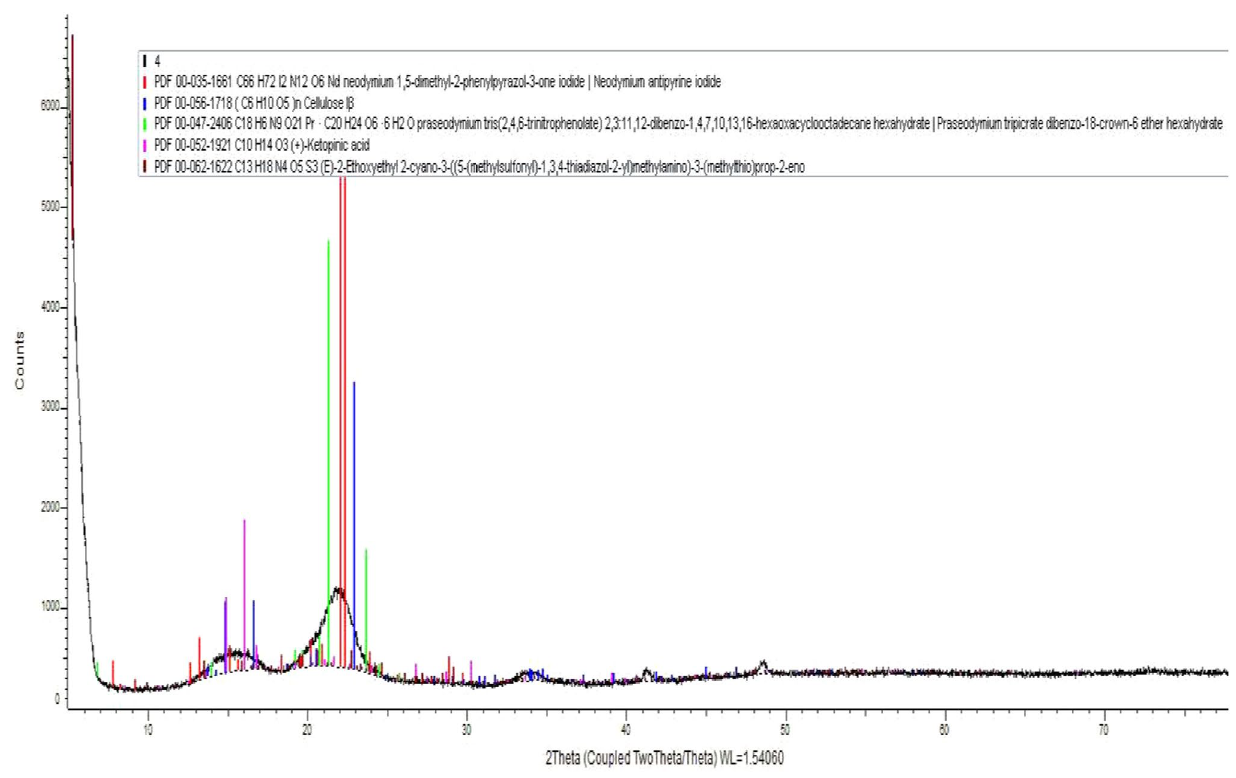
Fig. 6 X-ray powder diffraction result for the